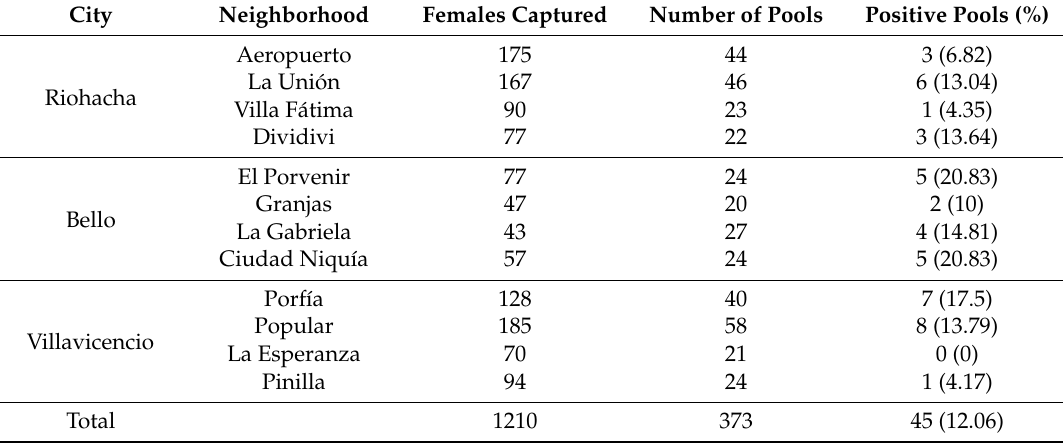
Table 1. Number of captured mosquitoes by neighborhood and pools analyzed for percent